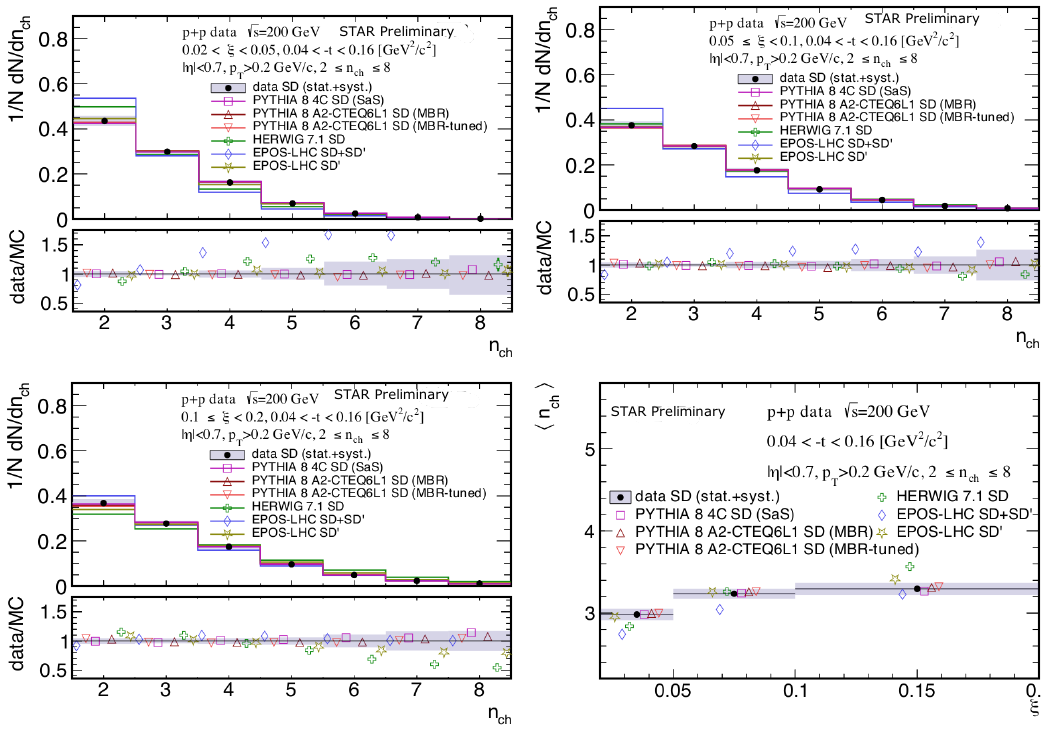
Figure 1: Primary charged-particle multiplicities shown in three ranges of the ξ : (top left) 0.02 < ξ < 0.05, (top right) 0.05 < ξ < 0.1, (bottom left) 0.1 < ξ < 0.2. 〉 as a function of ξ . Data are shown as full (bottom right) The mean multiplicity 〈 n ch dots with error bars representing the statistical uncertainties. Gray boxes represent statistical and systematic uncertainties added in quadrature. Predictions from MC models are shown as histograms or the open symbols. The bottom panels show ratios 〉 distribution, of data to the MC models predictions. In the ratio plots and in the 〈 n ch points representing different MC models are spread within bins for better